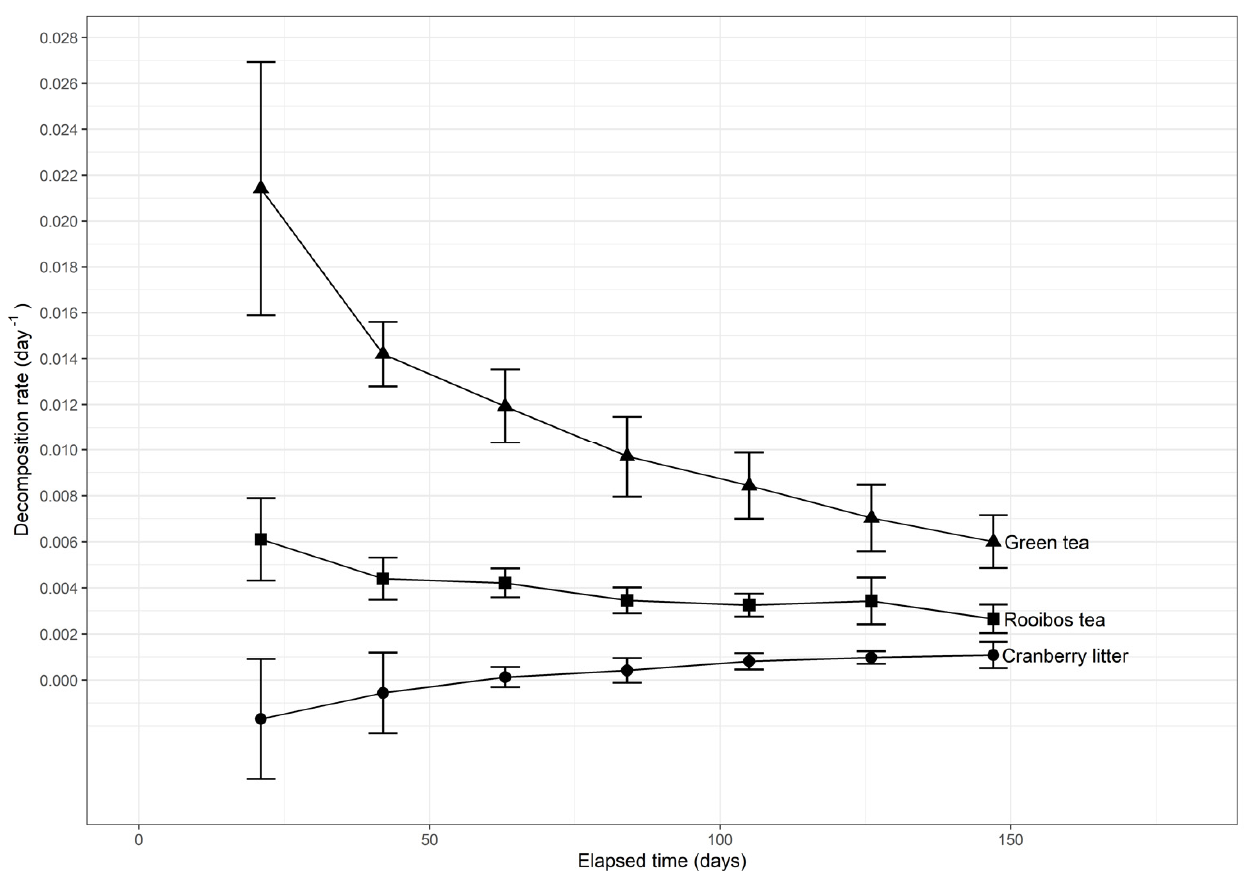
Figure 6. First order kinetics of teas and cranberry litter under field conditions. The decomposition patterns (initial decomposition rate k 1 and fractal coefficient h) of the hydrolyzable (soluble matter and holocellulose) and non-hydrolyzable (lignin and cutin) fractions are presented in Figure 8. The hydrolyzable fraction of green tea showed higher fractal coefficients (h = 0.6) than that of rooibos tea (h = 0.4), with both different from zero. The fractal coefficient for the non-hydrolyzable fraction of green tea and rooibos tea was h = 1.2 and h = 1.7, respectively, but were not different from one, indicating considerable deceleration through time and great potential for carbon